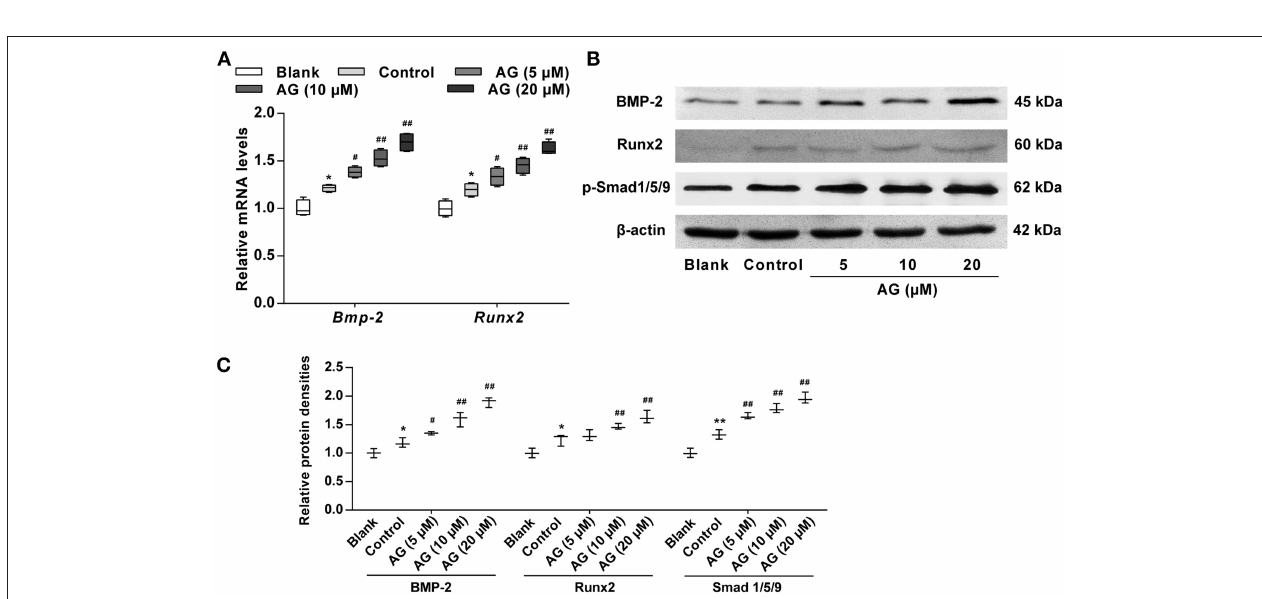
FIGURE 3 | The effects of AG on the mRNA and protein levels of BMP signaling molecules in mouse MC3T3-E1 cells. MC3T3-E1 cells were treated with AG at 5, 10, and 20 µ M for 24h. (A) Quantitative analysis of the mRNA levels of Bmp-2 and Runx2 using RT-qPCR. N = 4. (B) The protein levels of BMP-2, Runx2, and p-Smad1/5/9 were determined by western blot. (C) Quantitative analysis of the protein levels of BMP-2, Runx2, and p-Smad1/5/9 in AG-treated MC3T3-E1 cells. N = 3. All of the data are shown as the mean ± S.D. of the independent experiments. * P < 0.05, ** P < 0.01 compared with the corresponding blank group. # P < 0.05, ## P < 0.01 compared with the corresponding control